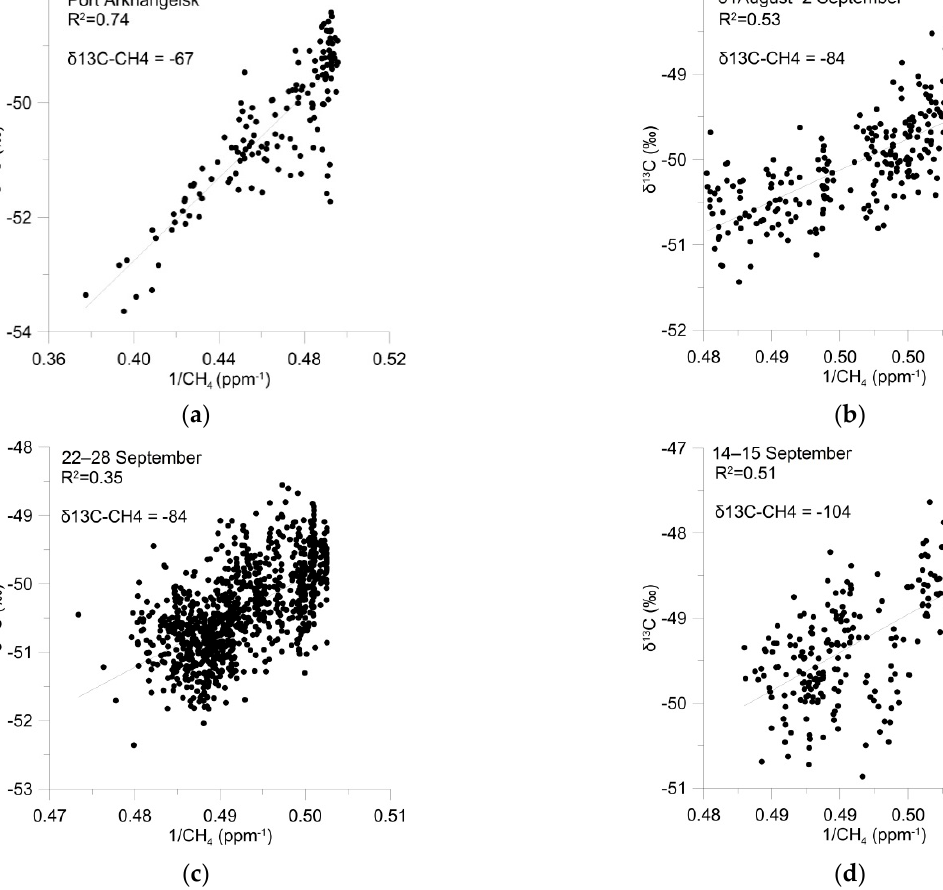
Figure 7. Keeling plot for some areas of AMK-85 (10 min averaging). ( a ) dominance of emissions from wetlands, the port of Arhangelsk. First line for panels ( b – d )—date (dd.mm).